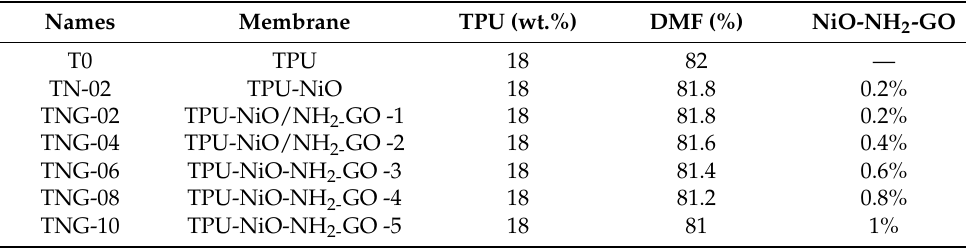
Table 1. Composition of TPU-NiO/NH 2 -GO